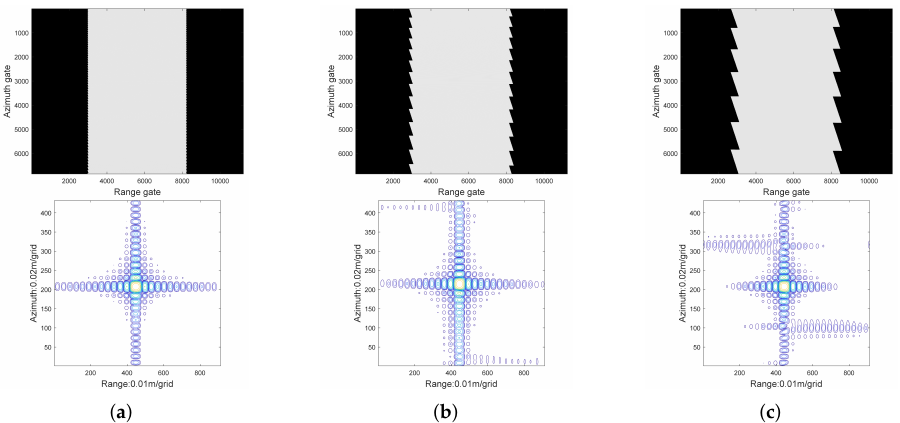
Figure 23. Variation diagram of carrier frequency and chirp rate with segment-varying parameters adjusted every ( a ) 100 pulses, ( b ) 500 pulses and ( c ) 1000 pulses, respectively.